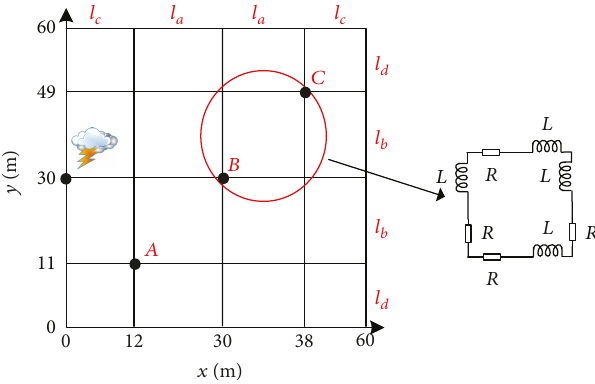
Figure 7: Lightning current hit in grounding grid.